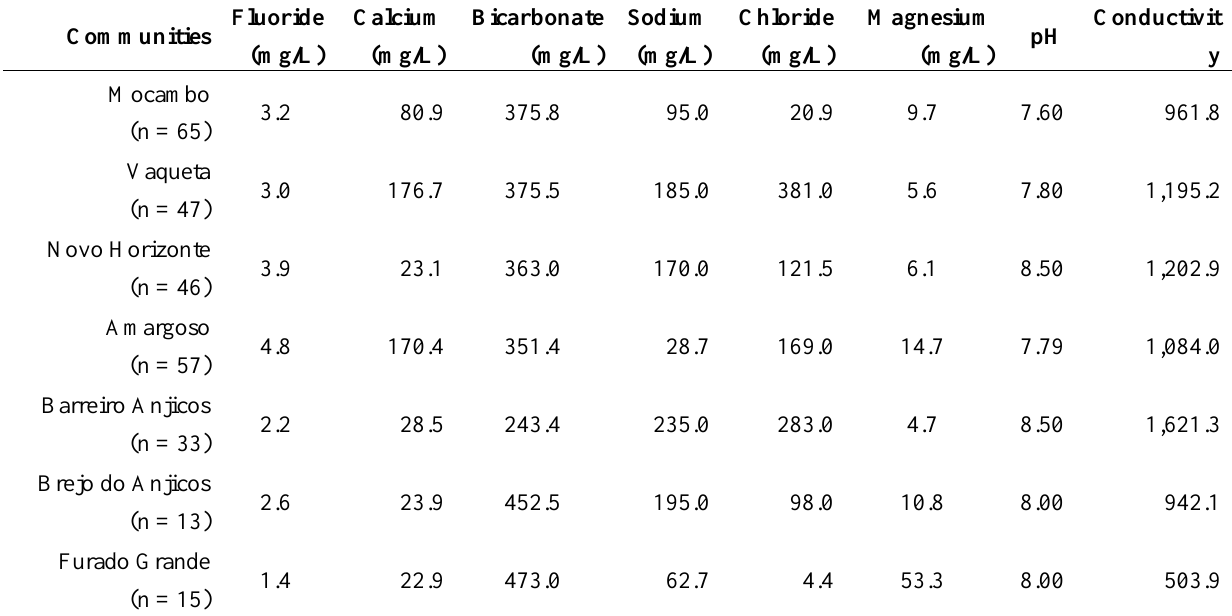
Table 2. Hydrochemical characteristics in different rural districts, São Francisco and Verdelândia,